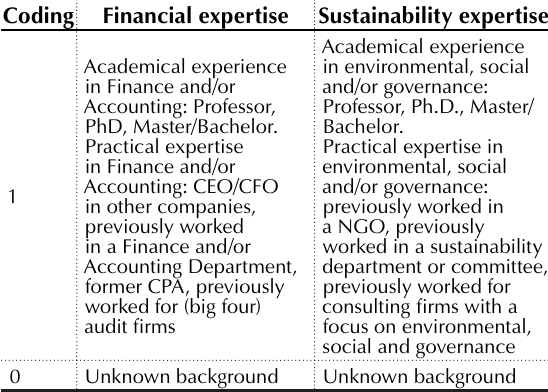
Table 2. Financial and sustainability expertise